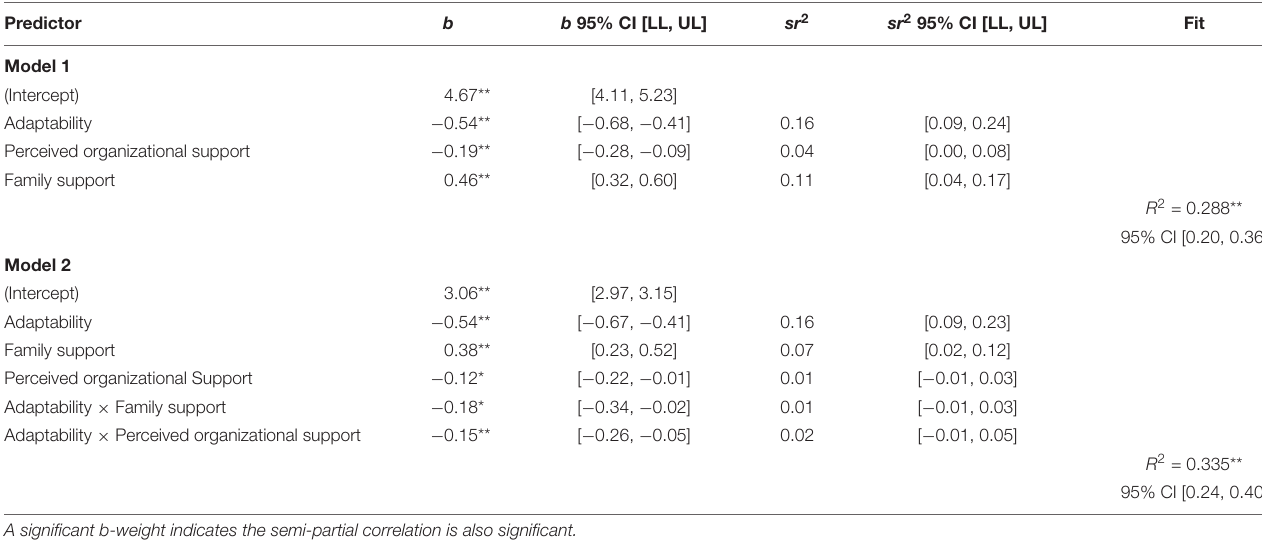
TABLE 2 | Regression results predicting COVID-related PTSD symptoms ( N =